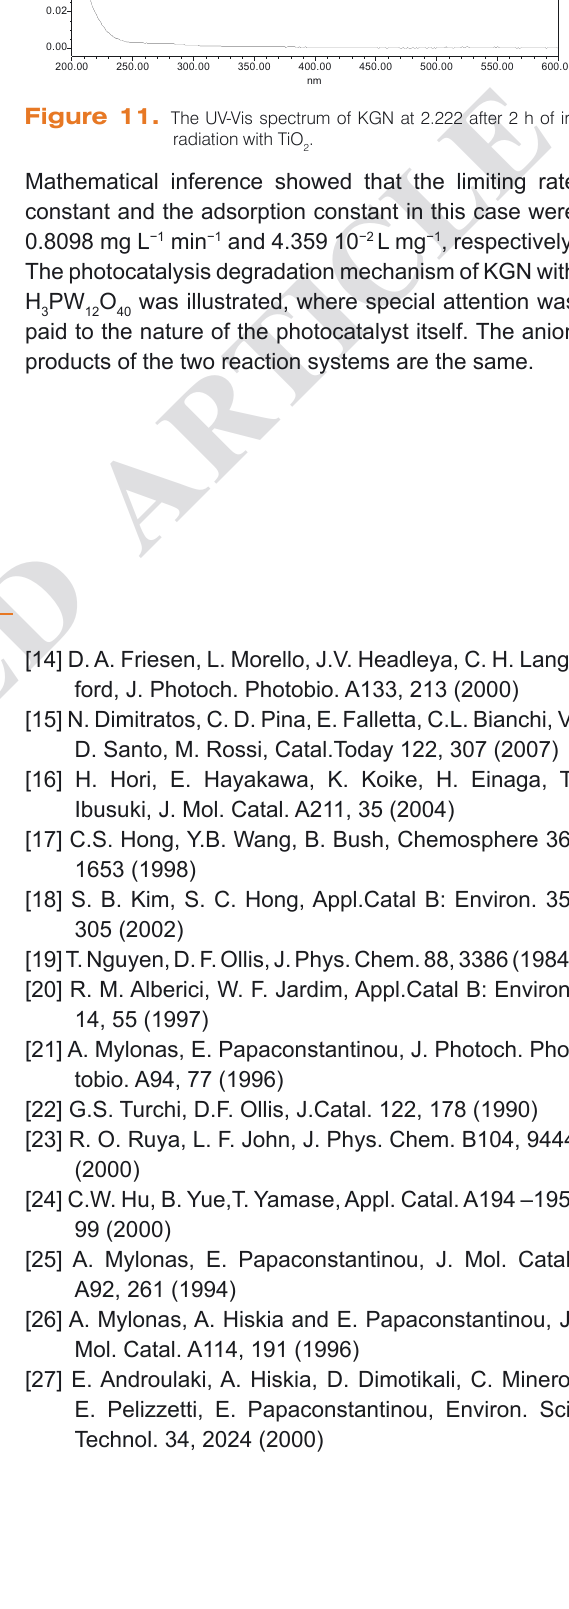
0.000.020.040.060.08 A U nm200.00 Figure 11. The UV-Vis spectrum of KGN at 2.222 after 2 h of ir-